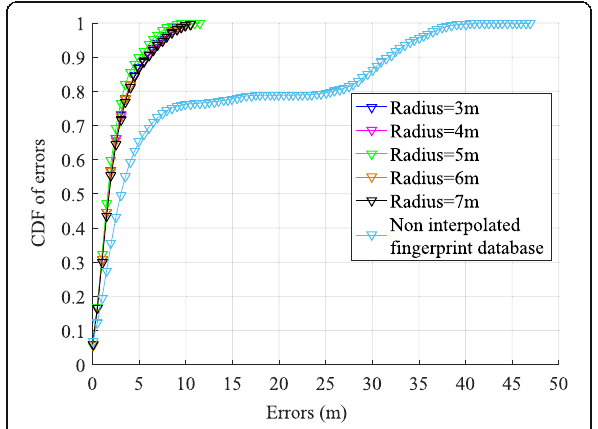
Fig. 10 CDFs of errors in localization under different cut-off radius